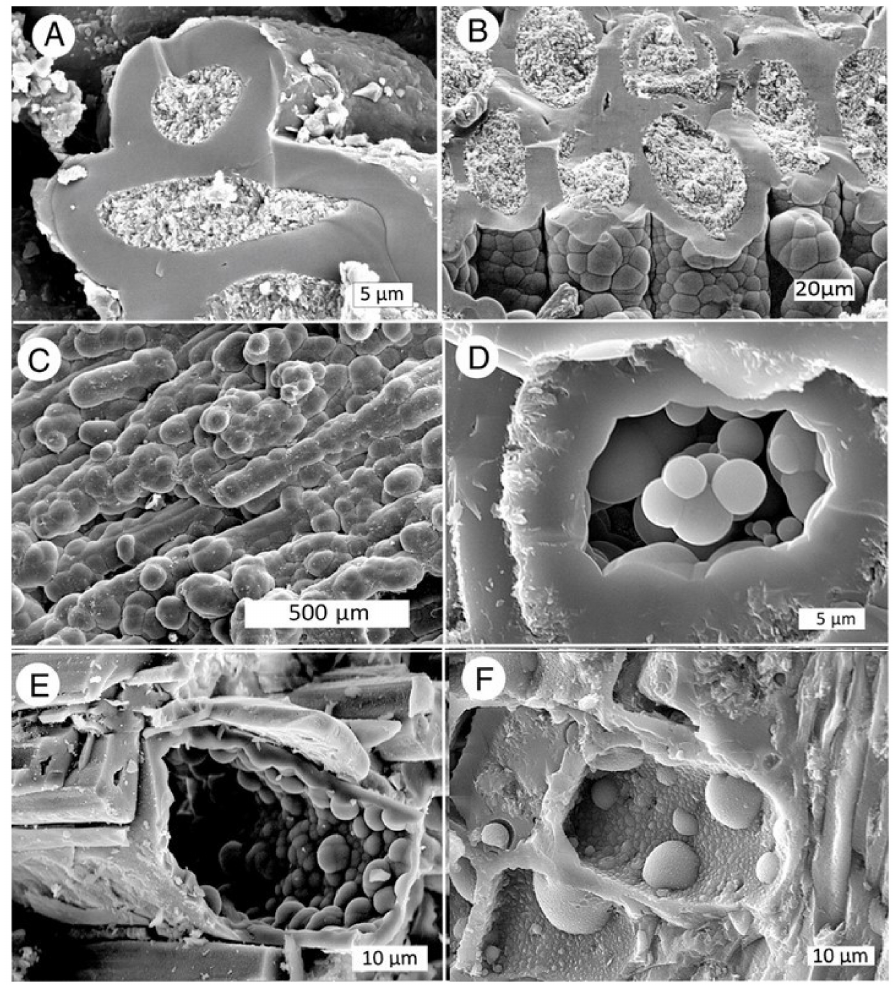
Figure 25. Botryoidal opal-A from Miocene locations.( A – E ) are from Nevada, USA. ( A , B )